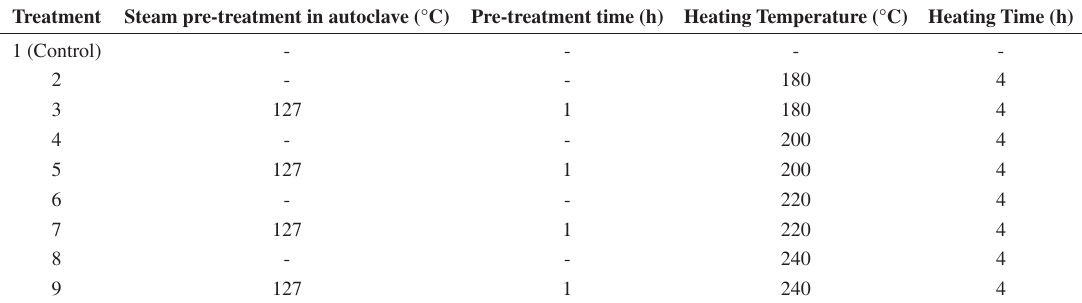
Table 1. Two-step steam-heat treatments performed in rose gum and Sydney blue gum